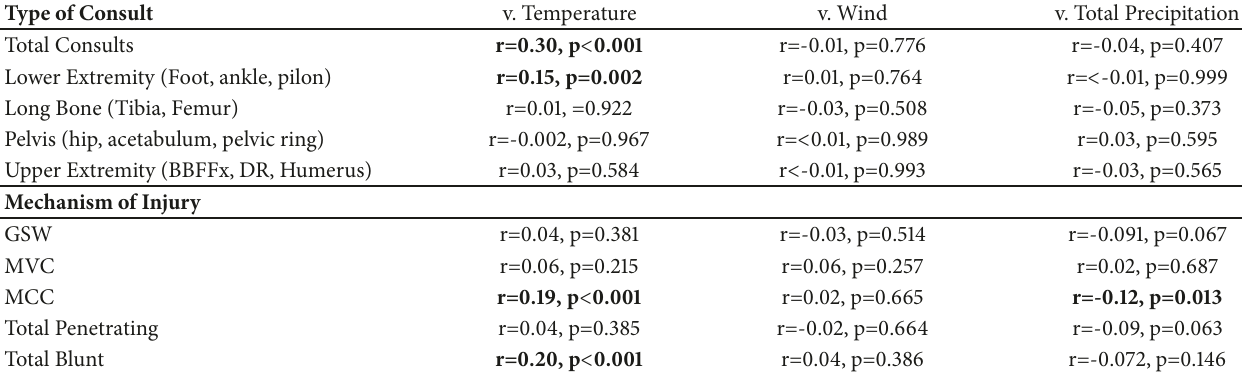
Figure 2:Relationship betweentotal orthopedic consults and weatherparameters:(a)averagedaily wind speed, (b) averagedaily temperature (r=0.30, p < 0.001), and (c) average daily precipitation. Average daily wind speed and average daily precipitation were not significantly correlated to consult volume. Table 2: Pearson Correlation analysis of weather parameters versus consult type and mechanism of injury. Statistically significant values are in